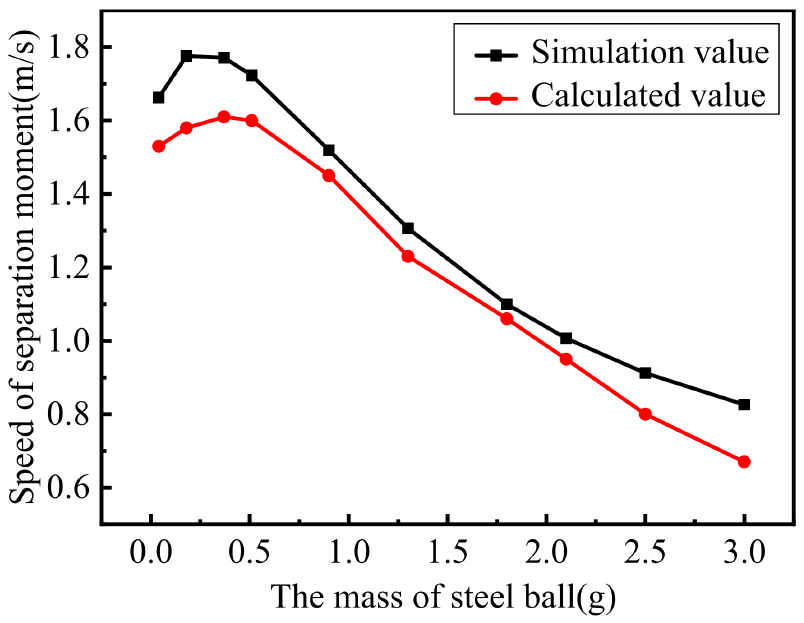
Figure 7. Comparison of experimental and simulated values of the first set of experiments.